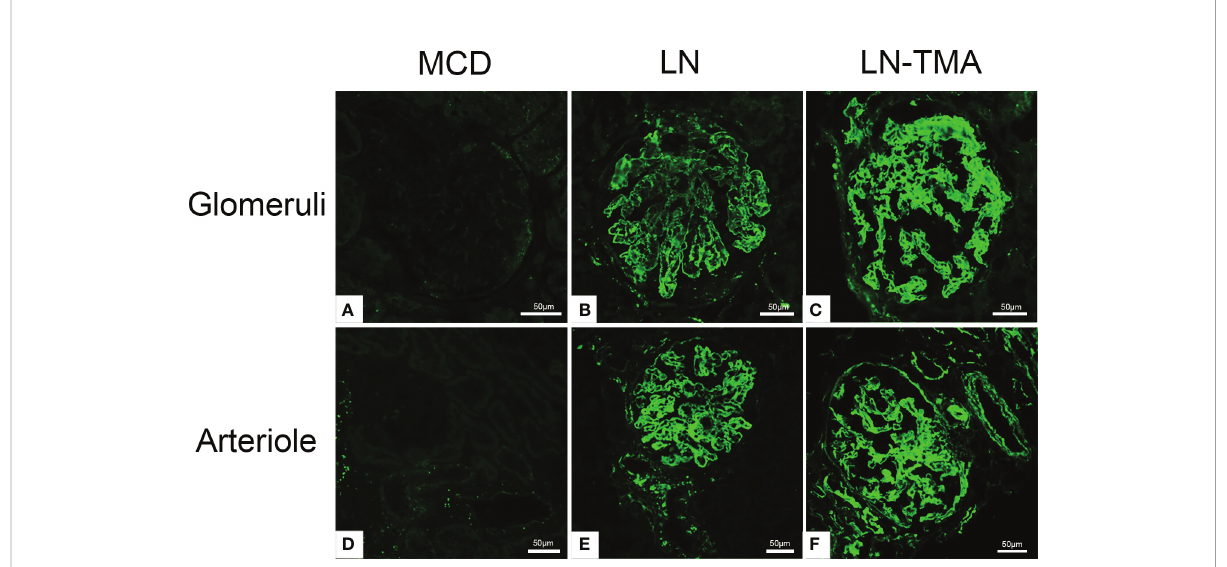
FIGURE 6 Frozen sections for C4d using immuno fl uorescence among MCD (A, D) , LN (B, E) , and TMA (C, F) patients. (A, D) Staining for C4d was negative in MCD renal tissues. (B, E) Moderate granular positive staining for C4d along the glomerular capillary and arteriole in LN renal tissues. (C, F) Strong granular positive staining for C4d along the glomerular capillary and arteriole in TMA renal tissues. Scale bars represent 50 m